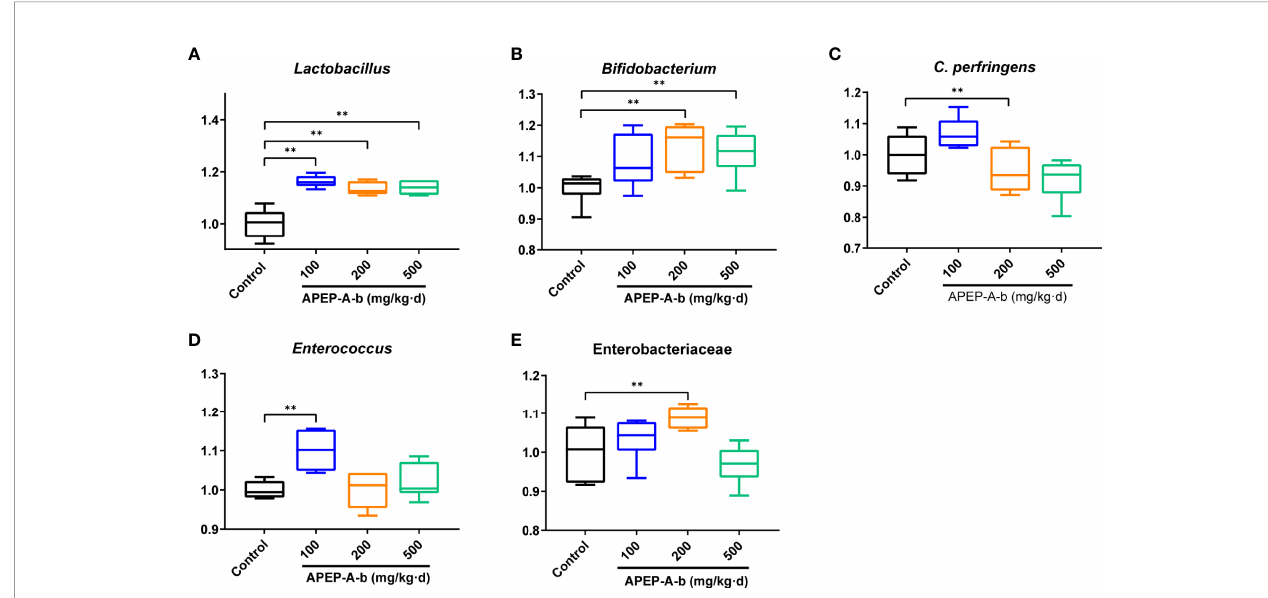
FIGURE 5 | The bacterial counts in faces determined by the culture method. Lactobacillus (A) , Bi fi dobacterium (B) , Clostridium perferingens (C) , Enterobacteriaceae (D) , Enterococcus (E) . Data are represented as the means ± SD (n = 6). **P < 0.01 compared with the Control